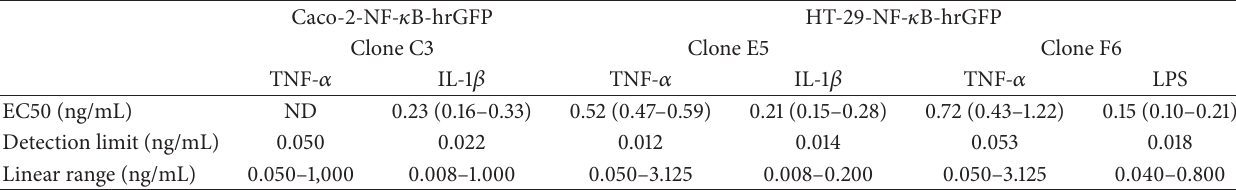
Table 1: Determination of EC50, detection limit, and linear range for different clones.